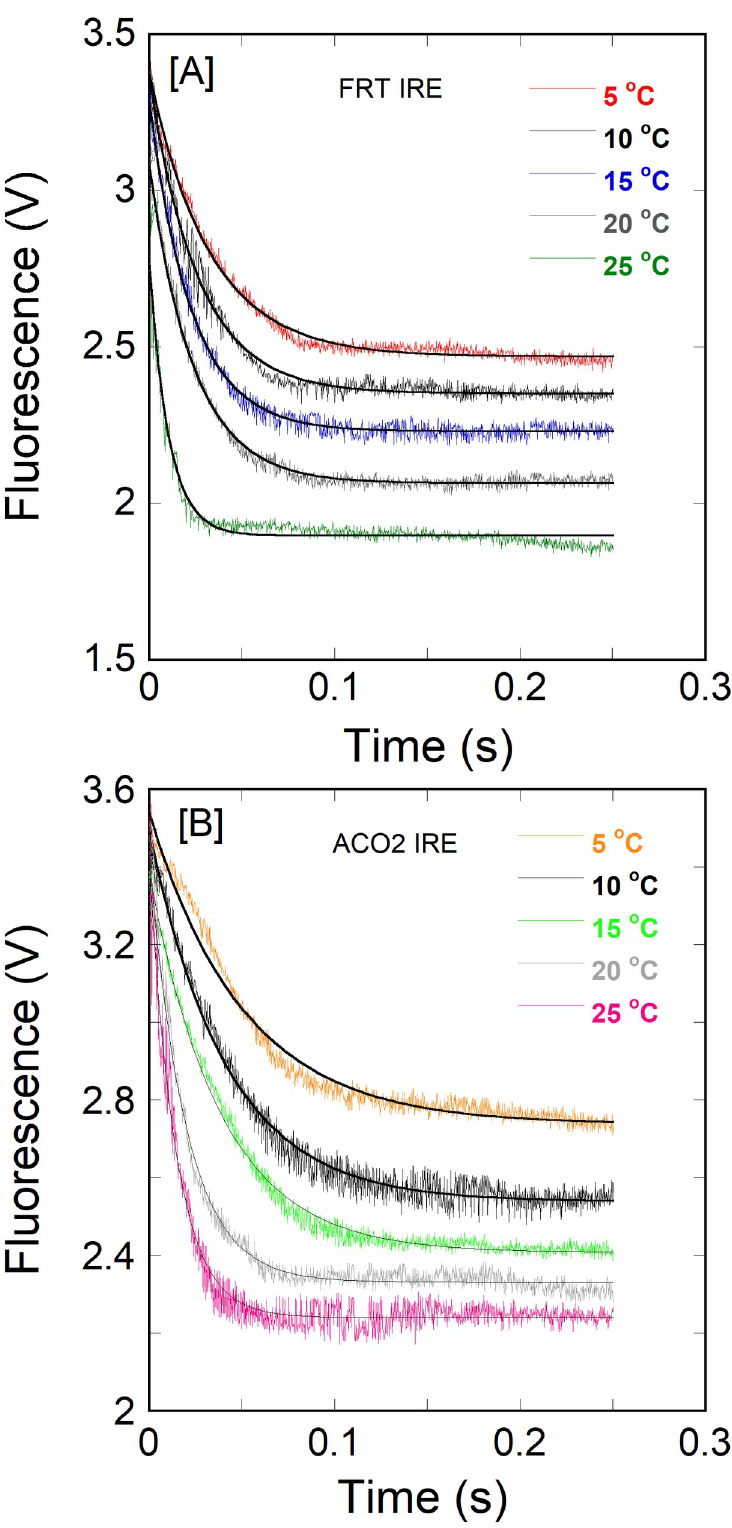
Fig 4. Temperature-dependent kinetic measurements of IRE RNA binding to eIF4F. Kinetic plots show the time course for the interaction of eIF4F at 0.1 μ M (final) mixed with 1.0 μ M (final) of (A) FRT IRE RNA and (B) ACO2